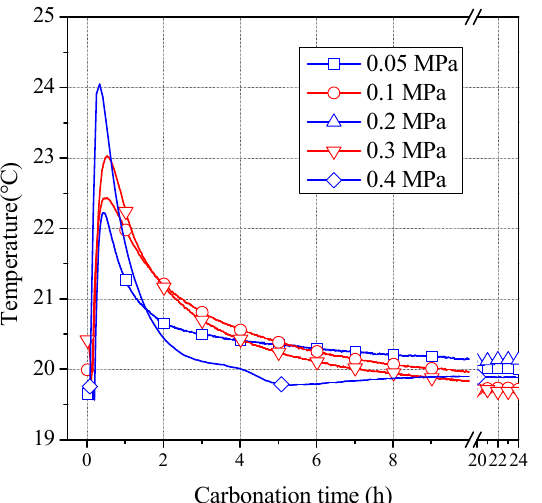
Figure 1. Temperature profiles of the carbonization kettle carbonated under varying CO 2 pressure.